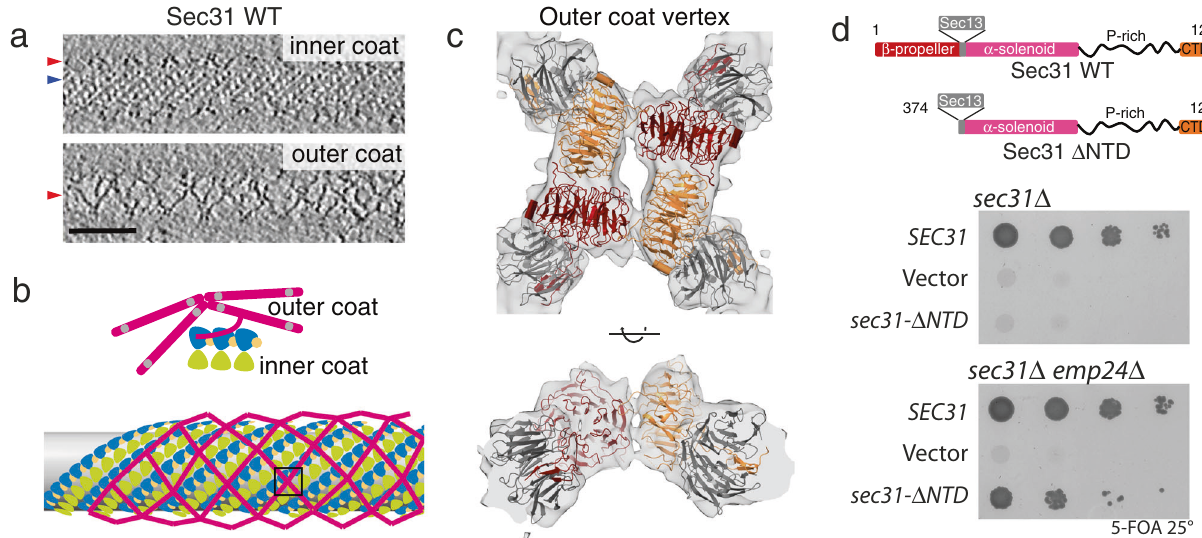
Fig. 1 Architecture of outer COPII coat vertices. a Slices through different z heights of a binned and fi ltered representative cryo-tomogram of wild-type COPII-coated tubule. In the top panel, density for the inner coat lattice is visible from the top and is indicated by a blue arrow, while the outer coat is cut through its side (red arrow). In the bottom panel, the outer coat is visible from the top, with its characteristic lozenge pattern (red arrow). Scale bar 50 nm. These images are representative of tubes seen on 286 tomograms from two separate experiments and data collection sessions. b Schematic representation of outer coat architecture. Sec13 – 31 subunits arrange in a lozenge pattern, around the inner coat that arranges in a tightly packed lattice. c , d Focus on the structure of vertices, boxed in this schematics. c Top and side views of the 12 Å subtomogram average of the COPII vertex, with rigid-body fi tted models (PDB 2PM6 and 2PM9). Sec31 protomers in dark red and orange, Sec13 in grey. d Top panel: Domain organisation of wild-type Sec31, and the Δ NTD mutant. Middle panel: a sec31 Δ yeast strain transformed with the indicated plasmids was tested on 5-FOA, revealing lethality associated with deletion of the NTD. Bottom panel: the same experiment repeated with a sec31 Δ emp24 Δ yeast strain reveals that depletion of emp24 rescues the lethality associated with deletion of the Sec31 NTD. Sigma threshold for contouring was set at 2.2 in ( c , d ). A representative result is shown from at least three